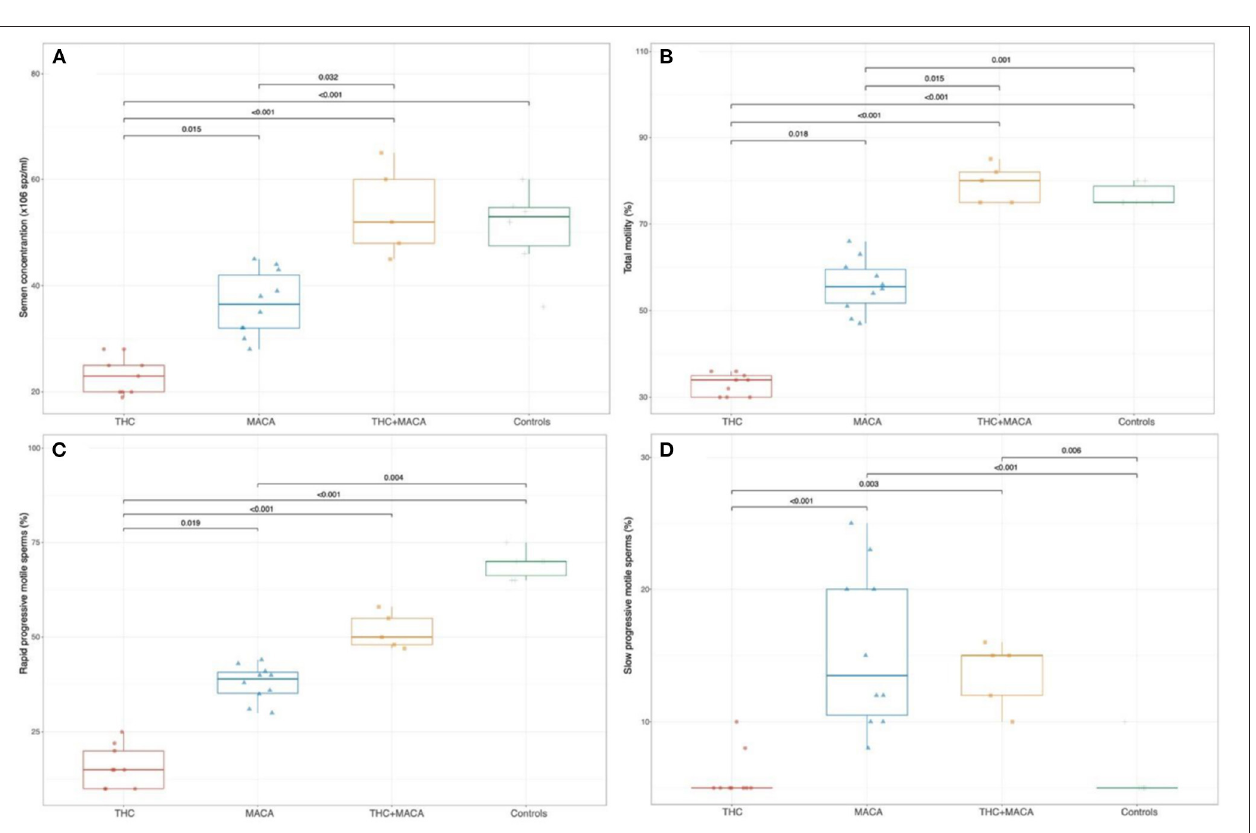
FIGURE 4 | Semen parameters in control and experimental groups. Boxplot showing the distribution of semen parameters stratified by experimental groups. Semen concentration (A) , total motility (B) , the percentage of rapid and slow progressive motile sperm (C,D) . Boxes represent the 25th − 75th percentile, the line represents the median and the whisker represents the min and max aside outliers that are reported outside the